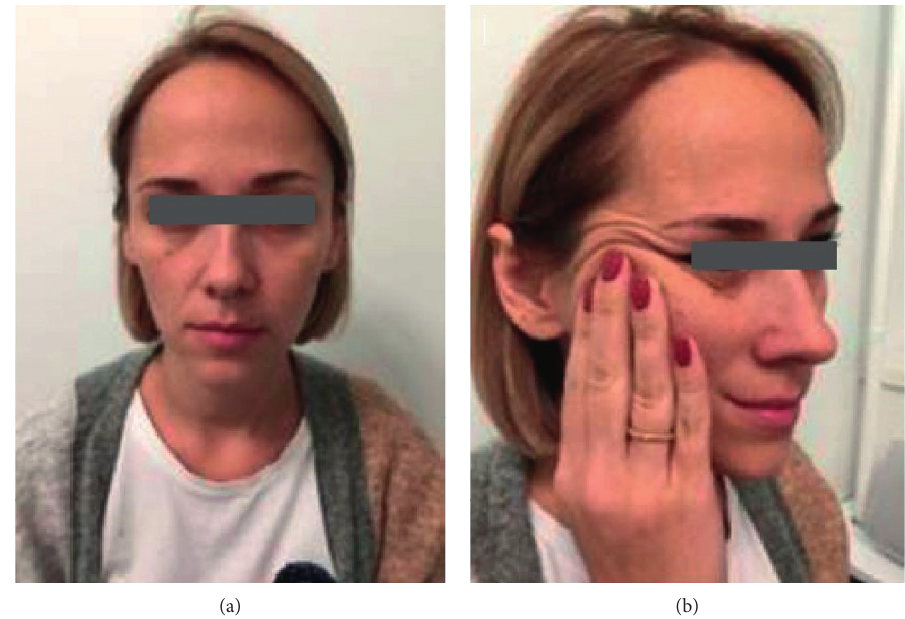
Figure 1: Before correction: facial asymmetry, nasolacrimal, and nasolabial sulci are deeper on the right (a); skin is easy folded